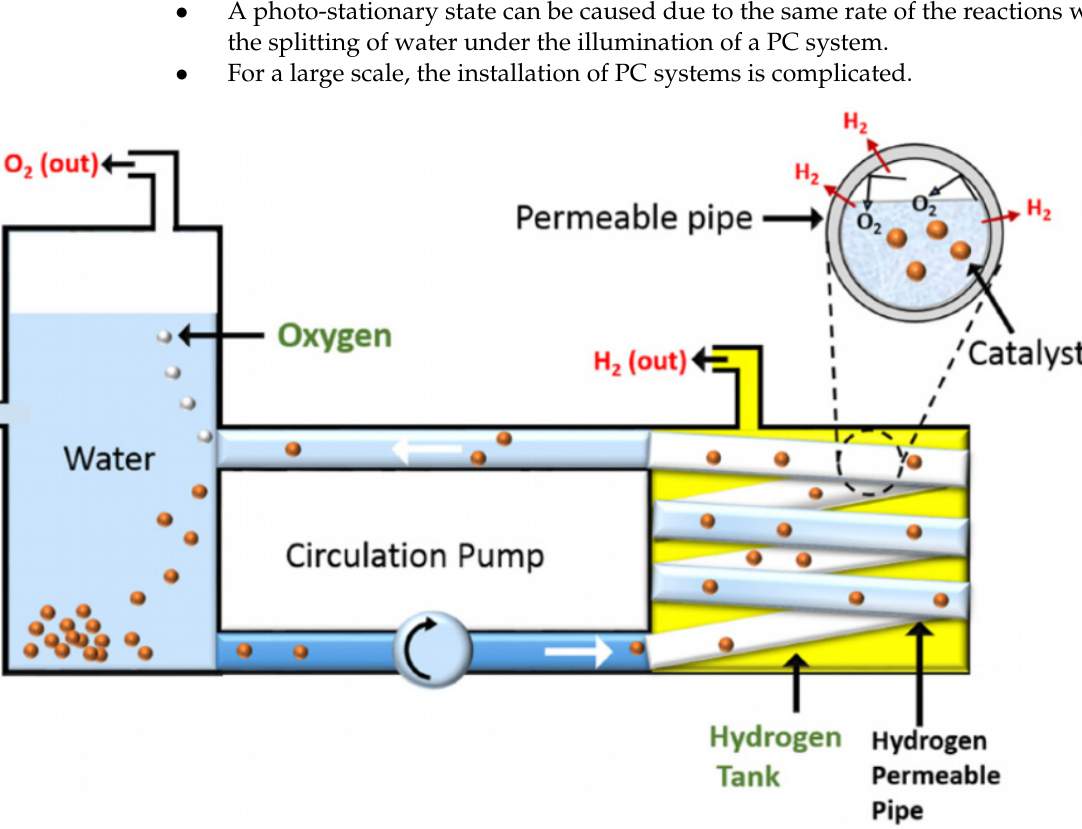
Figure 14. Scheme of photoelectrochemical (PEC) system: ( a ) a photoelectrode PEC system supplied by PV cell, ( b ) two-photoelectrode PEC system in parallel, and ( c ) a two-photoelectrode PEC system in series. 3.5. Bio-Photolysis/Photochemical The photo processes are used to separate hydrogen from water using sunlight. The photo processes can be classified as follows: